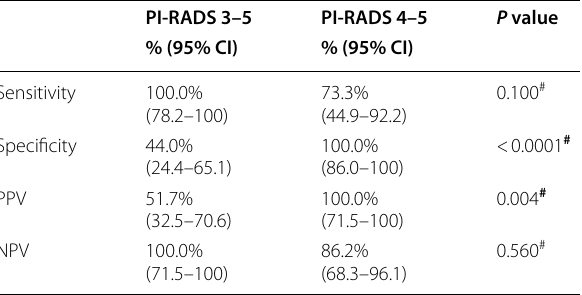
Data were presented as numbers and percentages # Chi‑square test/Fisher’s exact test